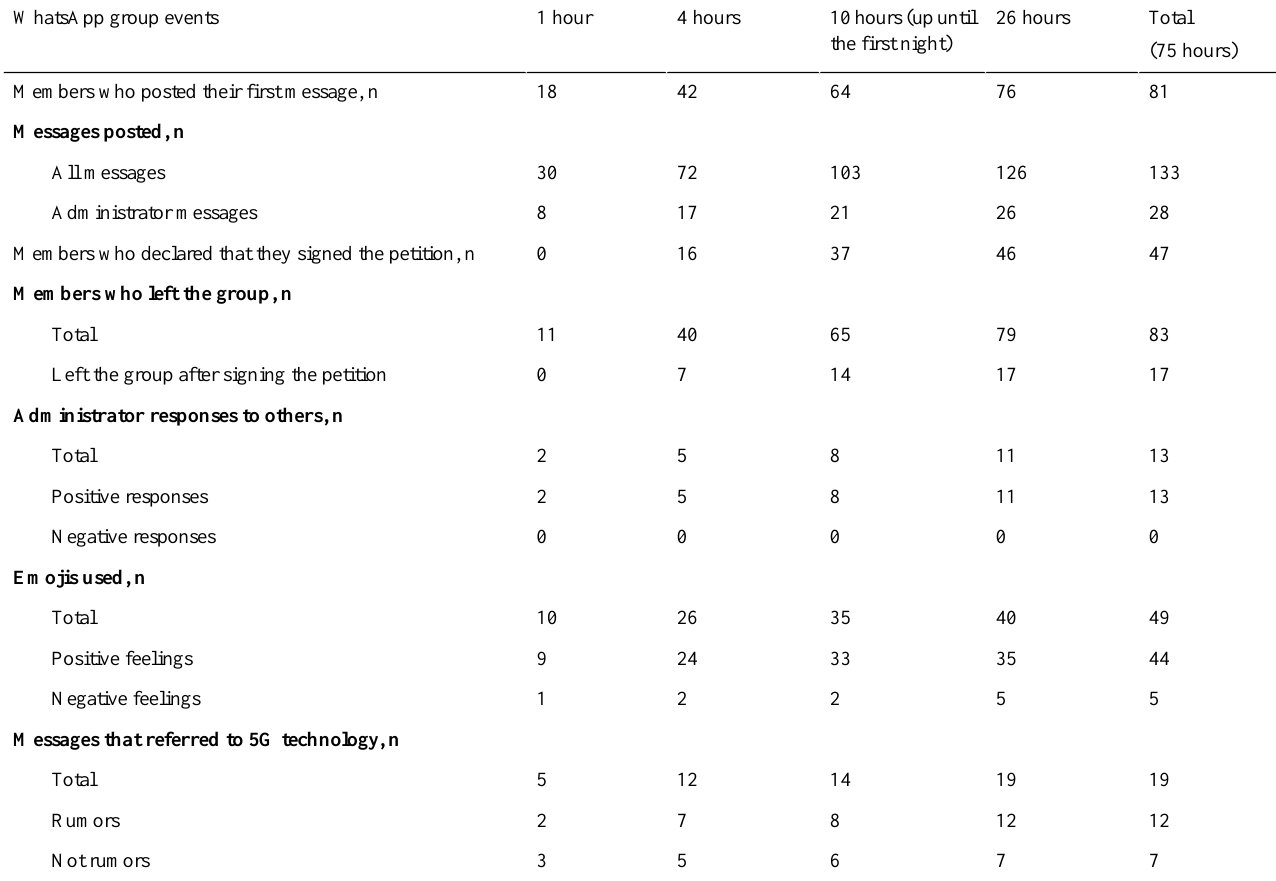
Table 2. Timing and extent of the different features of WhatsApp group events by the 205